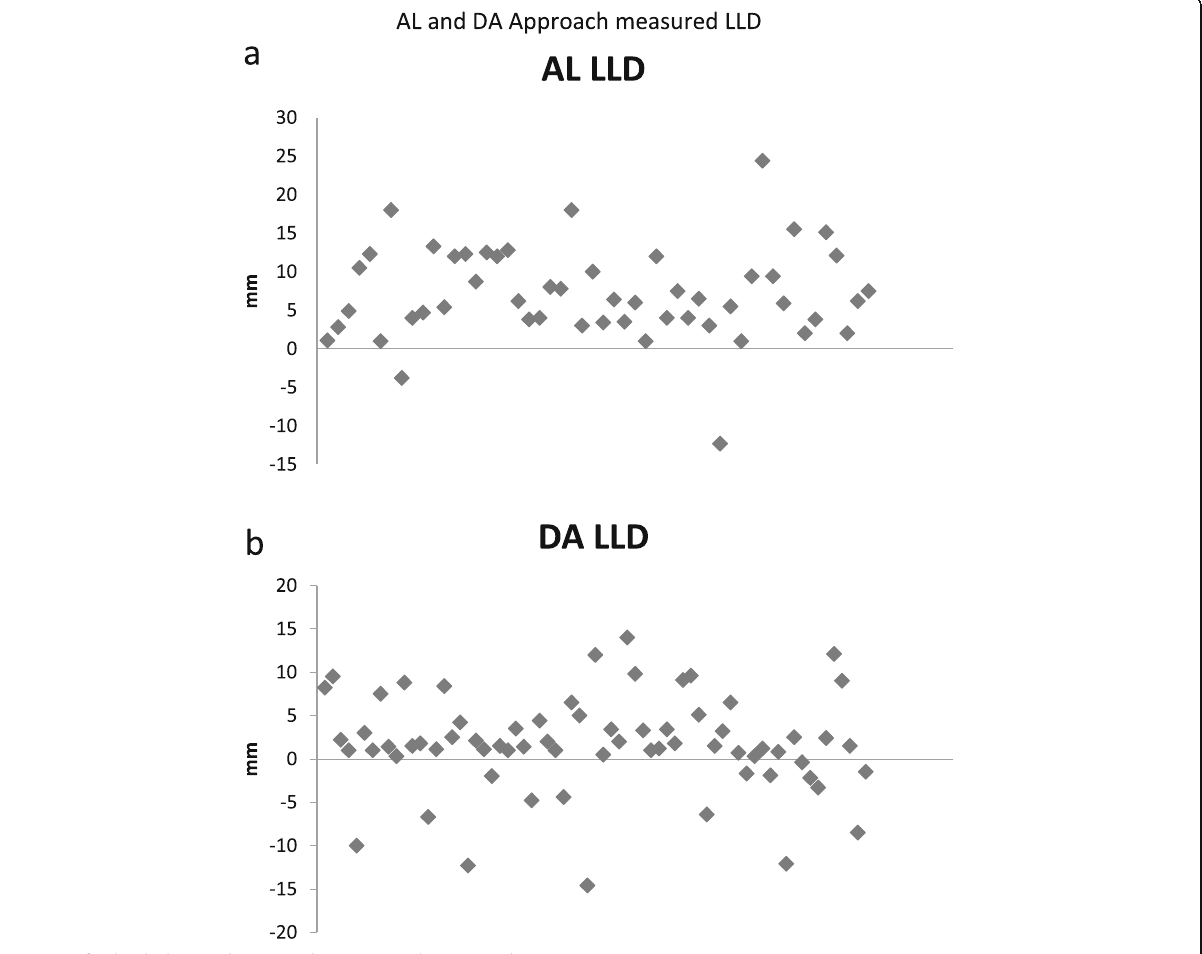
Fig. 3 a , b Bland-Altman Plot: AL and DA Approach measured LLD in